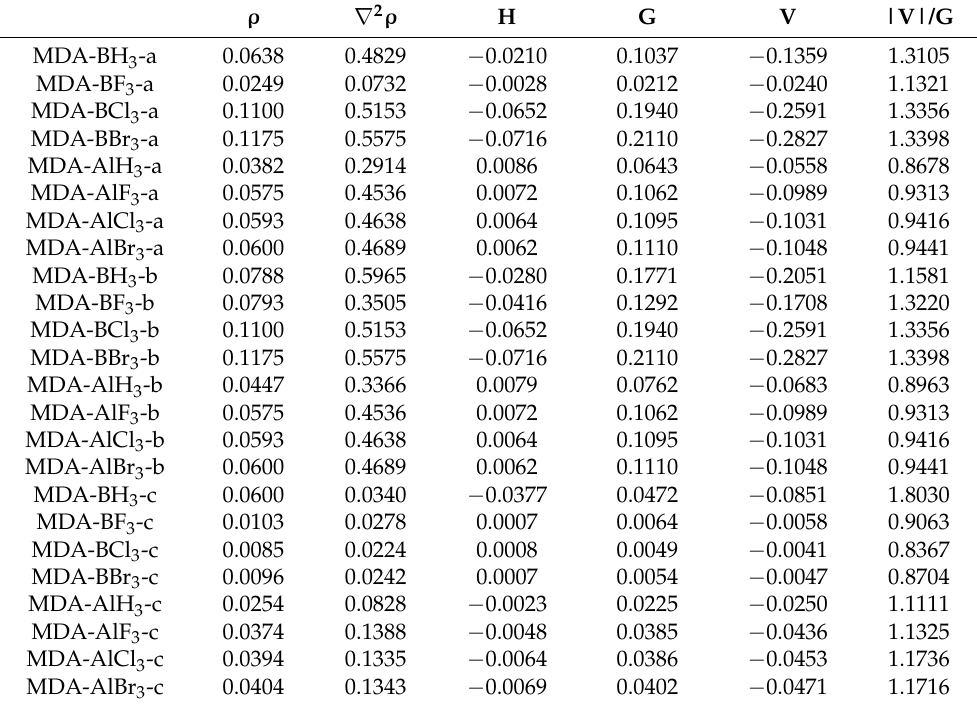
Table 2. Electron density ( ρ ), its Laplacian ( ∇ 2 ρ ), energy density (H), kinetic energy density (D), and potential energy density (V) at the B ··· O/C BCPs in the complexes, all in